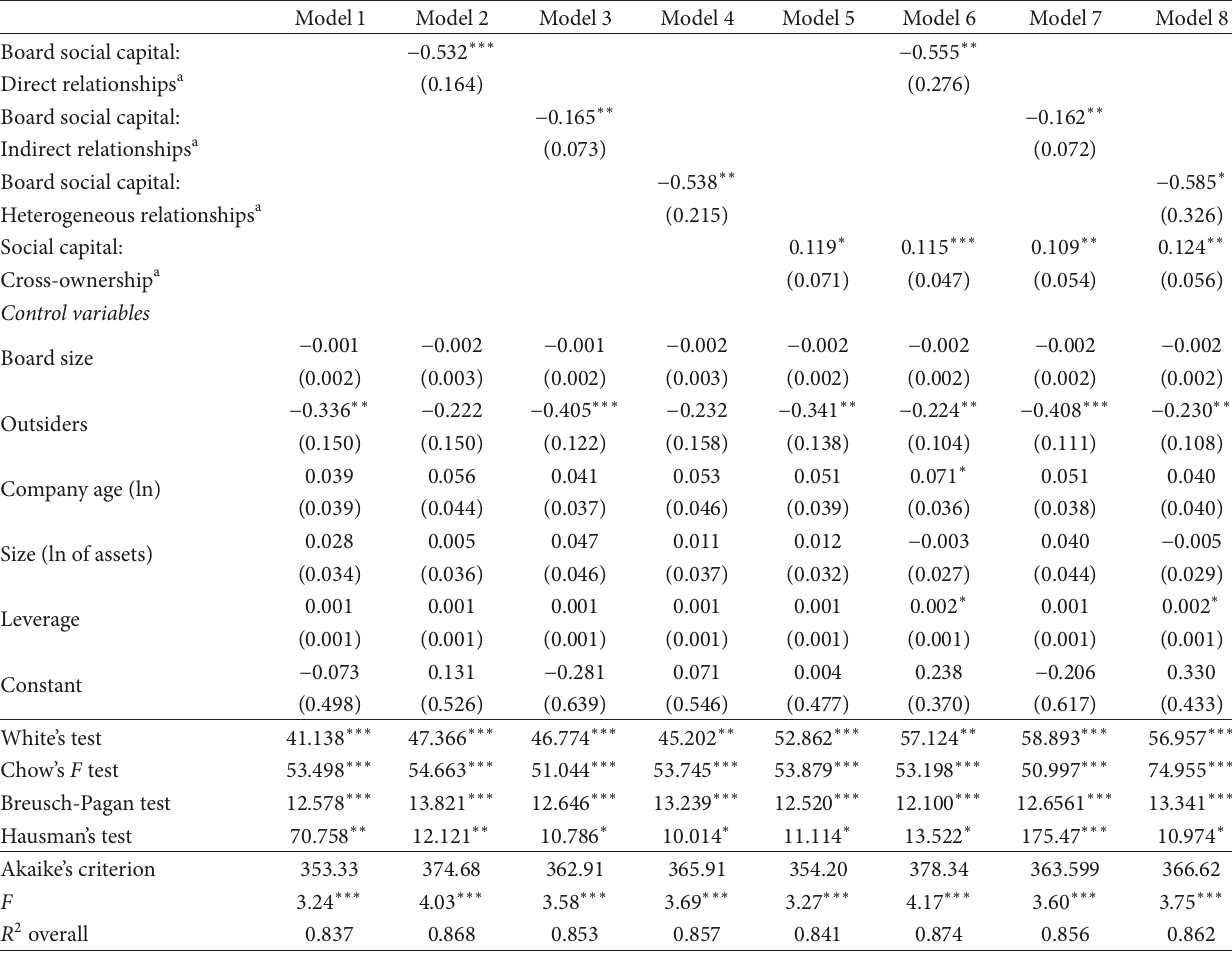
Table 2: Influence of Social Capital on the Implied Cost of Capital (Fixed Panel Data